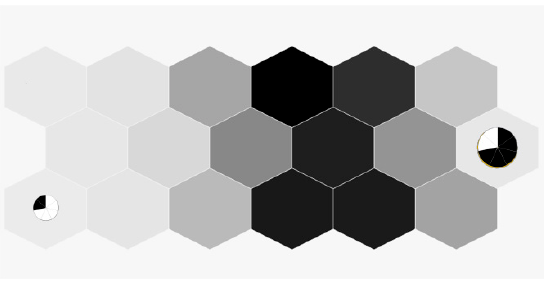
Figure 10. The Periodicity SOM for the employees of the cluster 2 of the Engineers department.